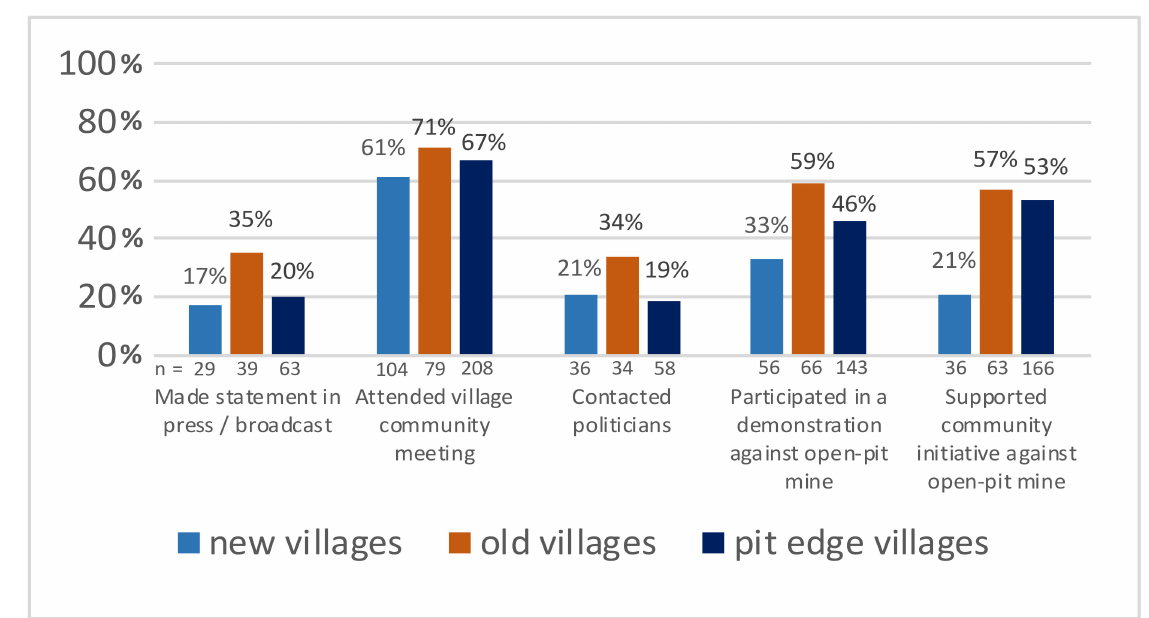
Figure 4. Activities in response to open-pit